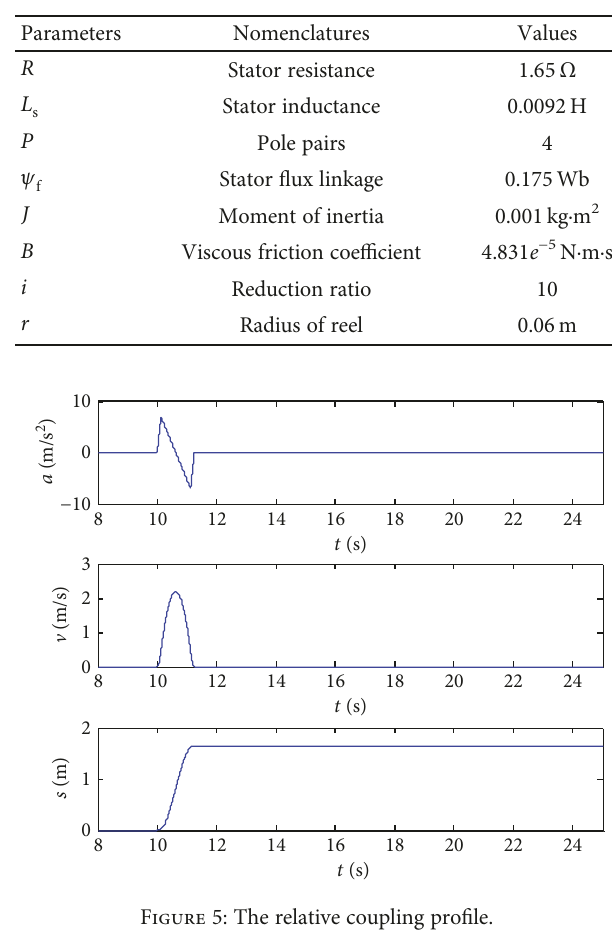
Table 1: Parameters of the hose-drogue assembly. Table 2: Parameters of the PMSM.